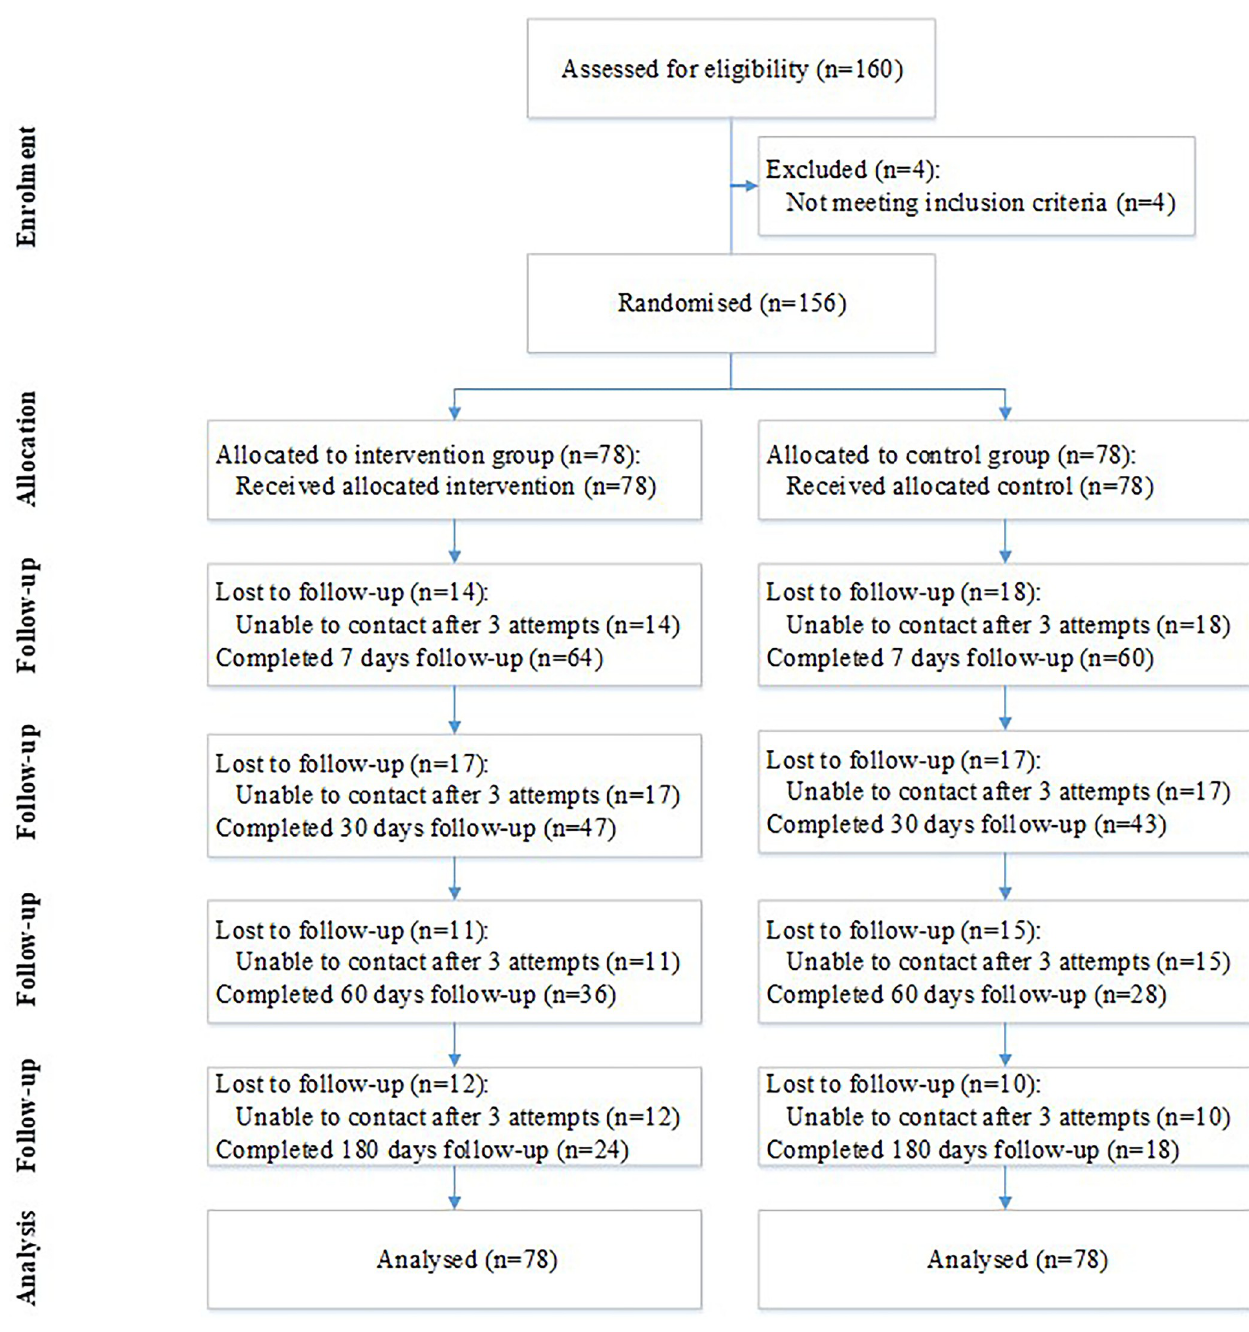
Of the 78 participants in the intervention group, 37.2% used PharmQuit in month one. After 6 months, only 2.6% were using PharmQuit, as shown in Fig 2. The number of times PharmQuit was accessed was highest during the 1 st month, which decreased over time. On day 180, 24 participants completed the 6-month follow-up. Fifty-four participants were unable to make contact. Thus, only 14 out of 78 participants (response rate: 17.9%) returned the